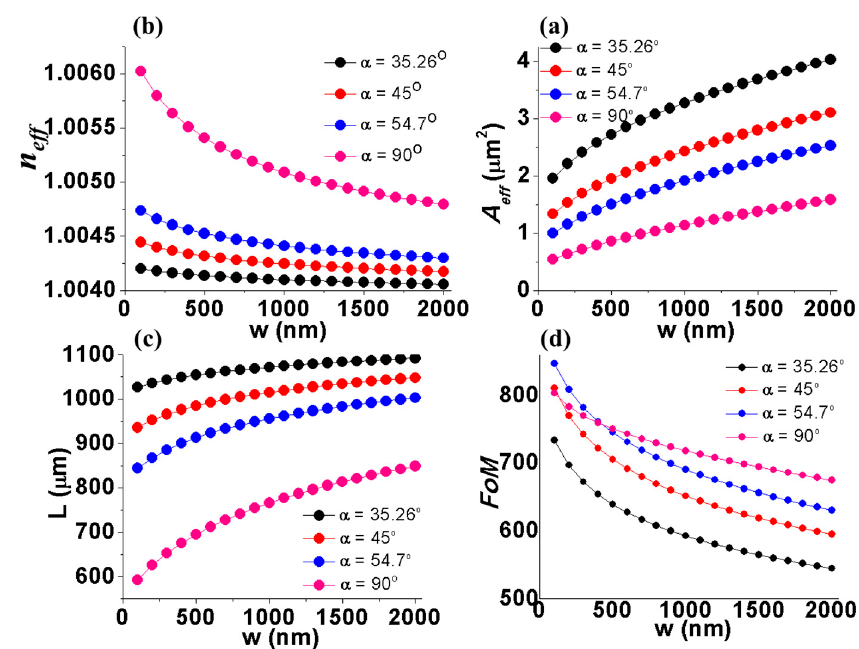
Figure 6. The propagation characteristics of the WPP mode depending on the width of the top surface of the wedge SPP waveguide, for four typical values of the sidewall corner ( α = 35.26°, 45 o , 54.7° and 90°): ( a ) effective mode index ( n eff ), ( b ) effective ode area ( A eff ), ( c ) propagation length ( L ) and ( d ) the figure of merit ( FoM ).